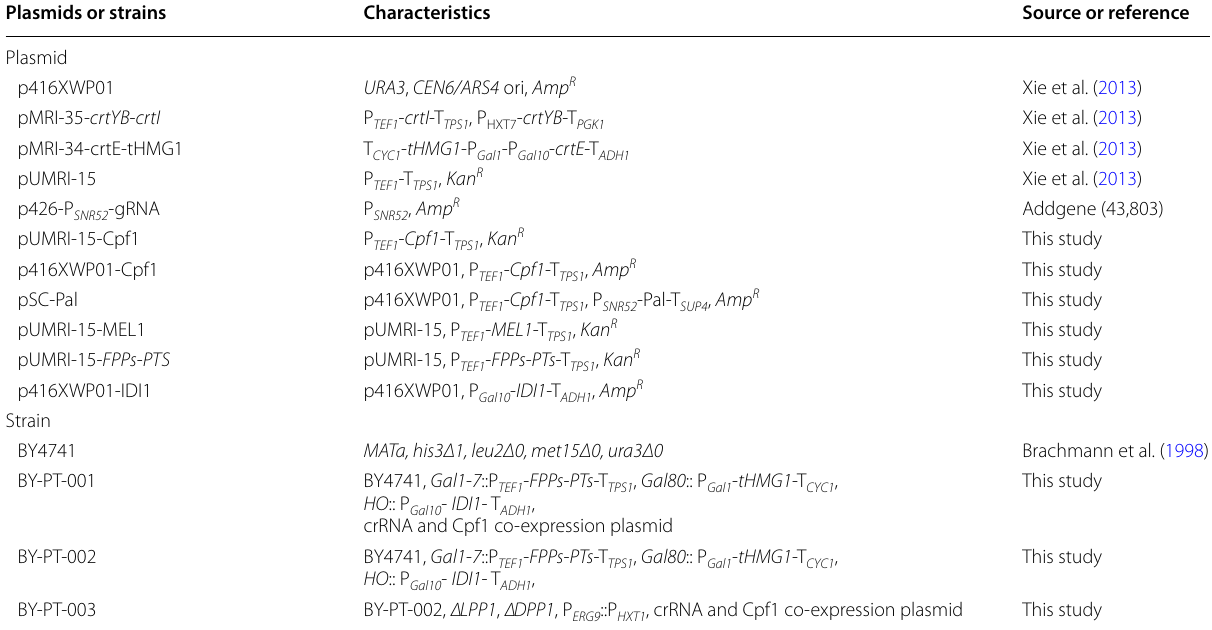
Table 1 The main plasmids and strains used in this study Plasmids or